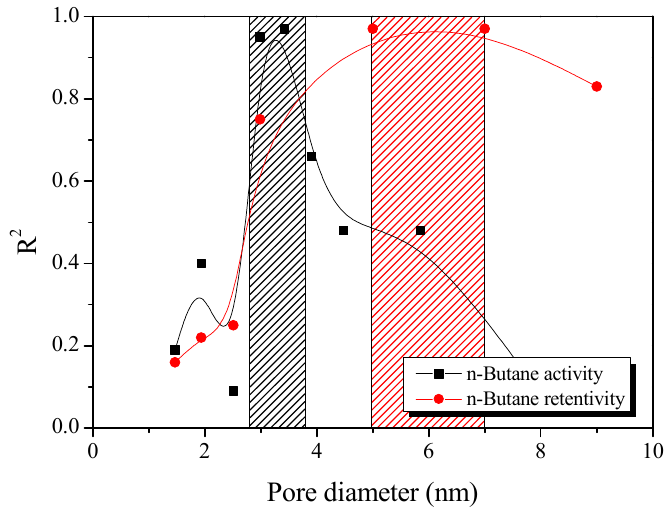
Figure 7. Correlations between the butane activity and retentivity of kenaf-derived activated carbons with pore volume.